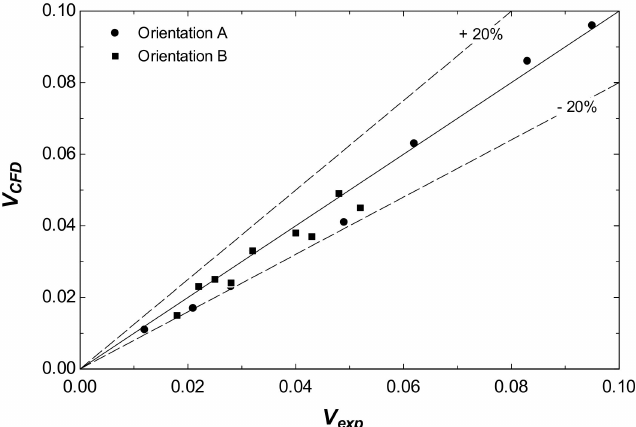
Figure 12. Comparison between experimental and numerical